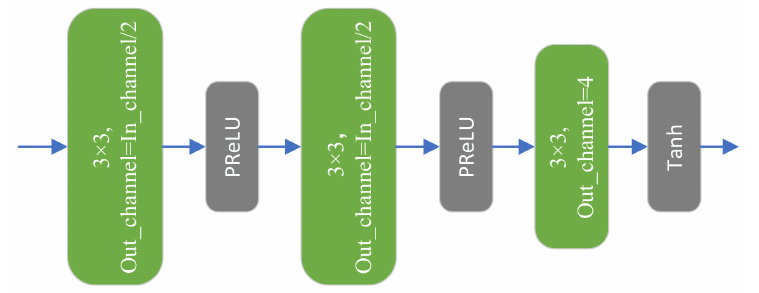
Figure 9. Detailed structure of the reconstruction